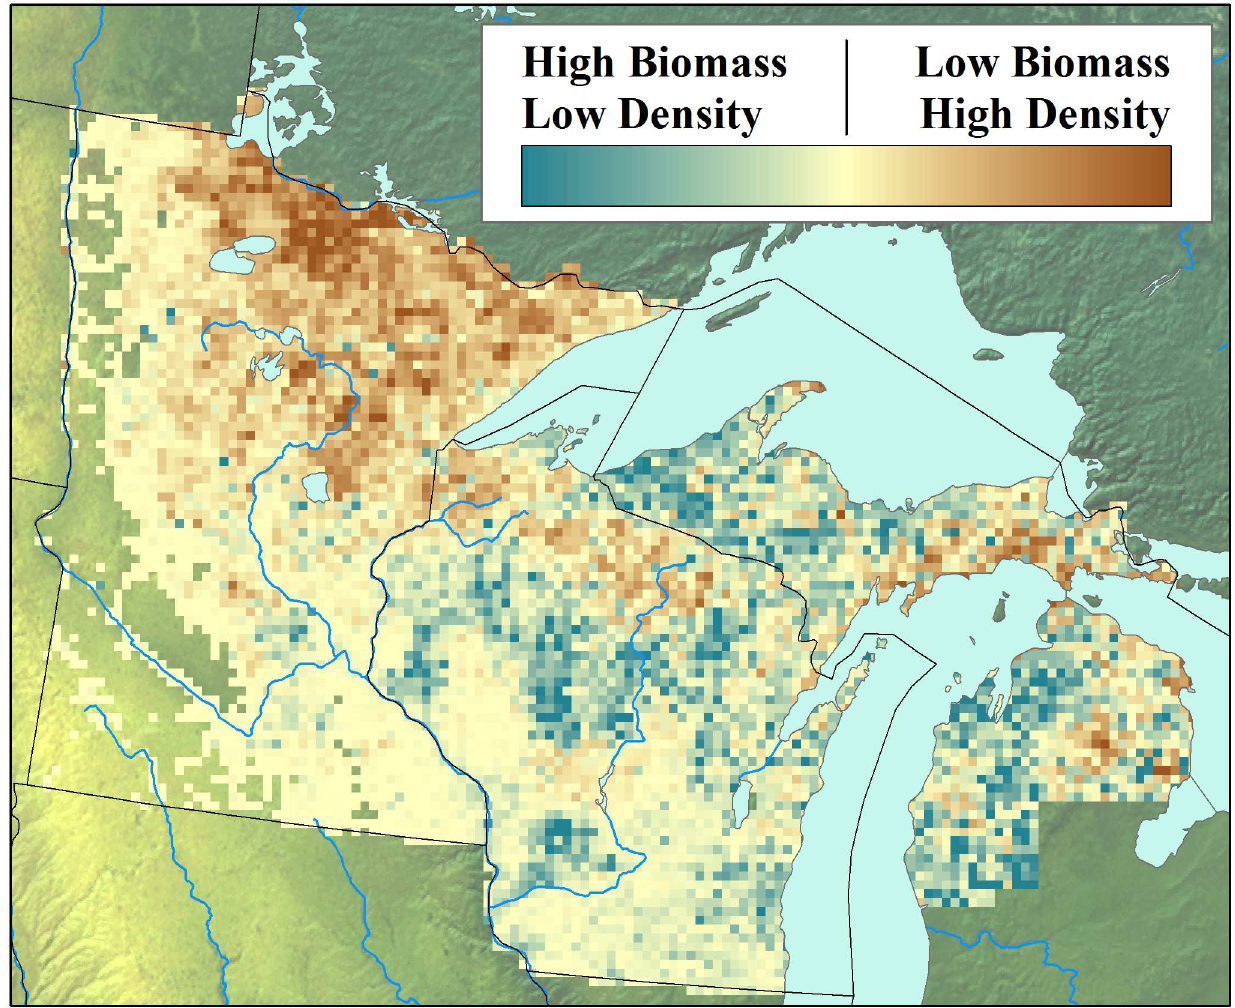
Fig 3. The ratio between biomass and stem density as an indicator of forest structure. Regionswith high stem density to biomass ratios (brown)indicate densestands of smaller trees, while regionswith low stem density to biomass ratios (green)indicatelarger trees with wider